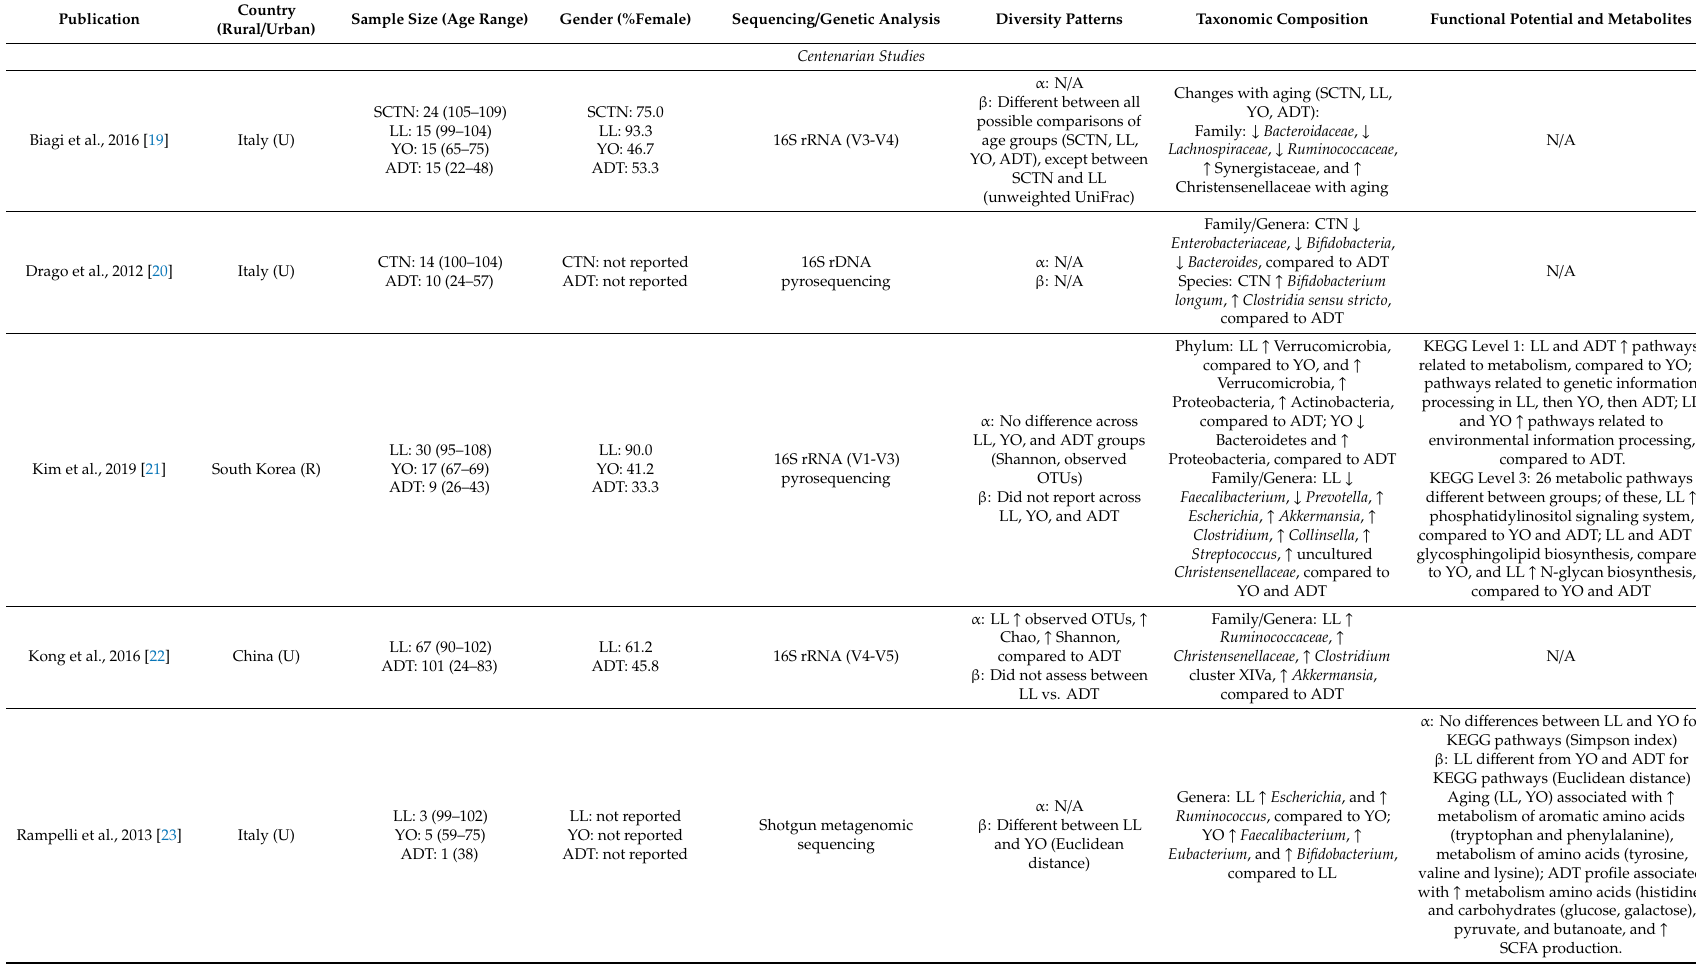
Table 1. Summary of reviewed